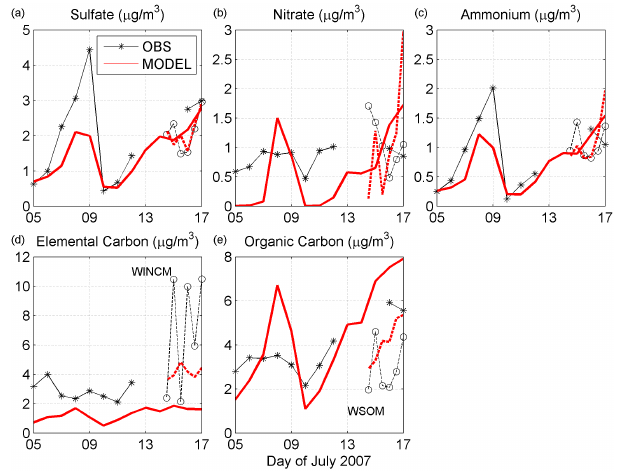
Figure 6. Qualitative comparison of (a) lidar range-corrected signal and (b) simulated PM 2 . 5 vertical profile over Milan on 12–17 July 2007. The white dashed line in the bottom panel denotes the simu- lated PBL